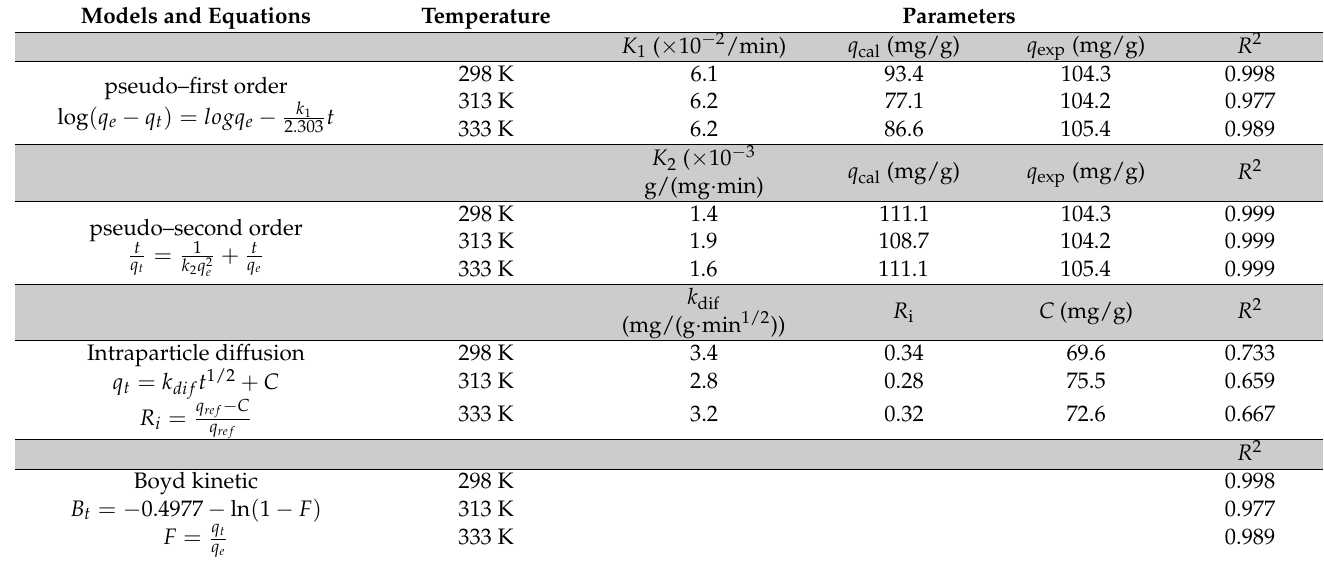
Table 1. Parameters obtained from different kinetics models for MB adsorption on rGO a